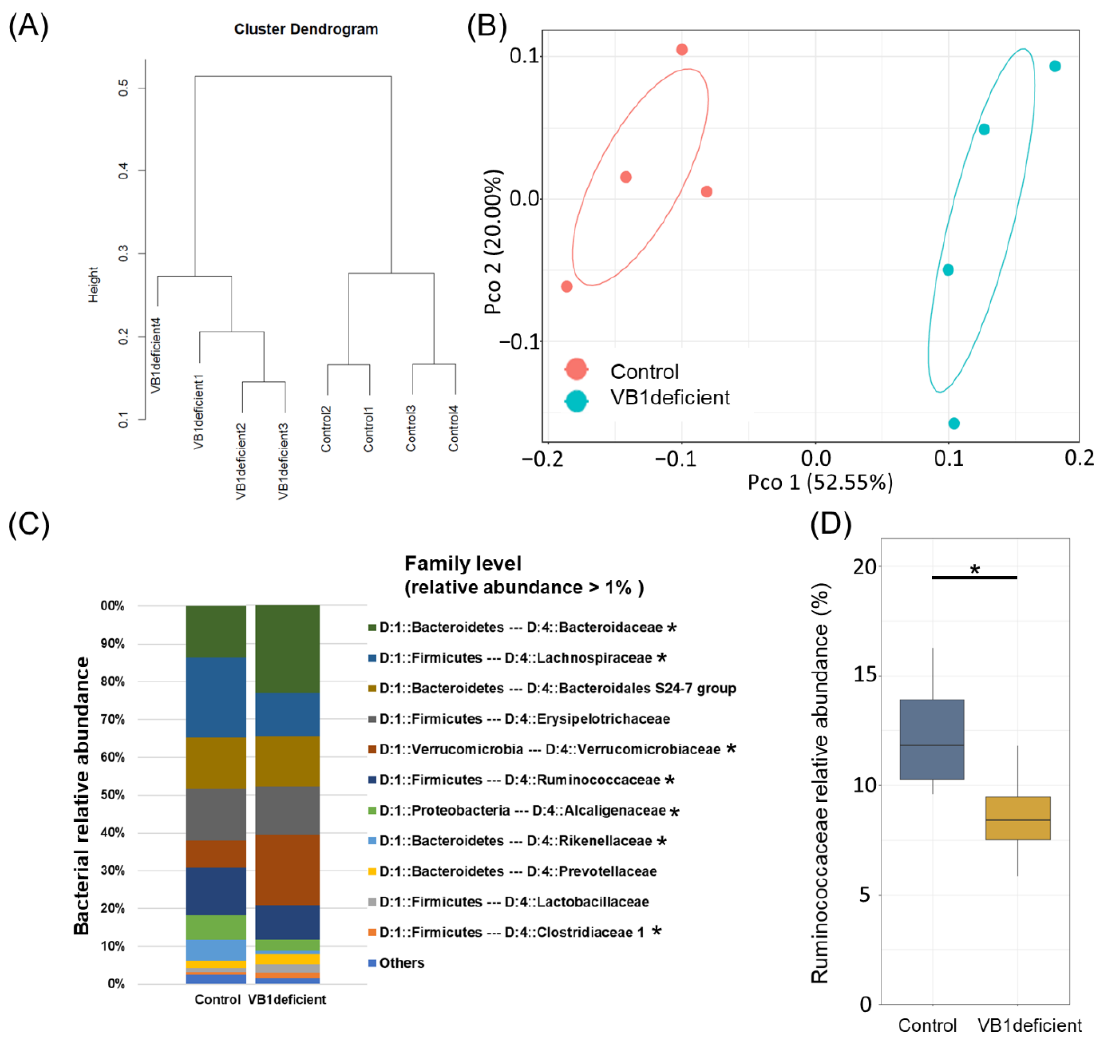
Figure 2. Correlation between gut bacterial community and vitamins in mouse data. ( A ) Cluster dendrogram generated using the Ward d2 algorithm for genus-level relative abundance. ( B ) Principal coordinate analysis results of the Bray–Curtis distance for genus-level relative abundance data (red, Control group; blue, Vitamin B1-deficient group). ( C ) Bar chart of mouse gut bacterial community composition at the family level. ( D ) Boxplot for comparison analysis of two groups in the Ruminococcaceae family. * p -value < 0.05.